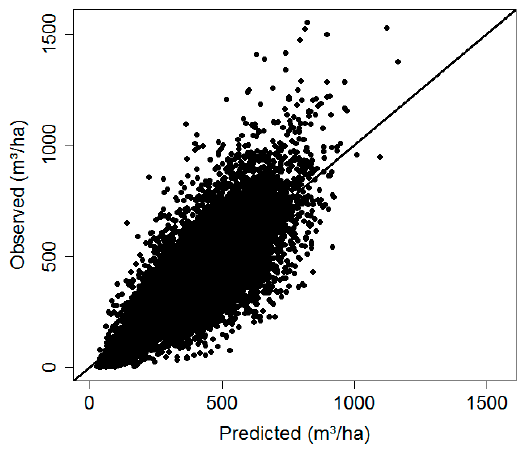
Figure 5. Observed versus predicted timber volume (m 3 / ha) of the non-linear logistic regression model from Equation Figure 4. Observed versus predicted timber volume (m 3 /ha) of the non-linear logistic regression model from Equation (11).